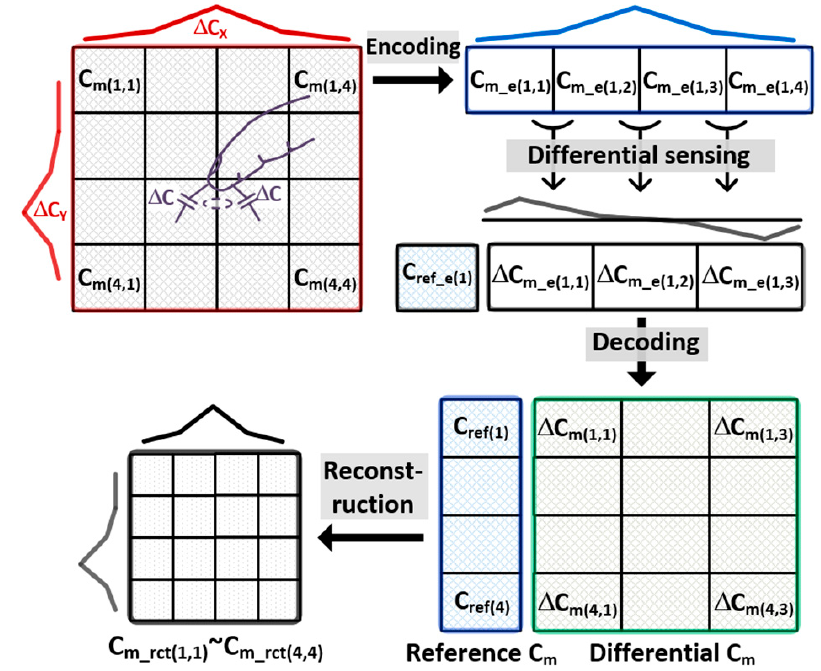
6 of 22 Figure 3. Measured time-varying jitter values at the leftmost, middle, and rightmost area of the TSP for 16 × 34 flexible AMOLED display. 2.2. Capacitance Reconstruction in Multidriving, Differential Sensing Architecture The C m reconstruction from ∆ C m is illustrated in Figure 4. For simplicity, let us con- sider that C m(1,1) –C m(4,4) are sensed by column-parallel differential sensing, and each TX electrode is simultaneously driven by 4-length orthogonal sequences. In this case, the AFE sensed the encoded capacitance difference ∆ C m_e(1,1) – ∆ C m_e(1,3) . Thus, the sensed readout signal (=3) is one less than the number of RX electrodes. We assumed that a finger is